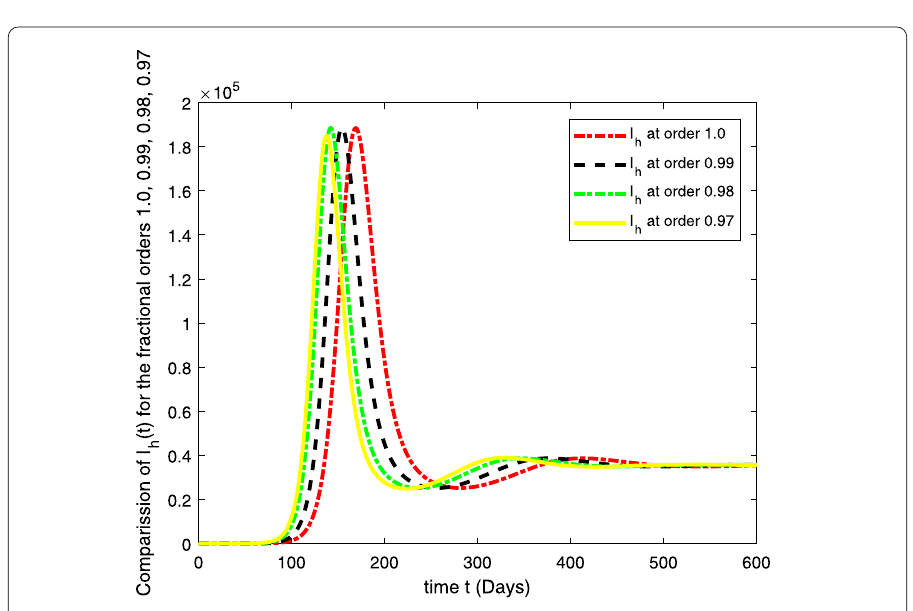
Figure 8 A comparative analysis of I h ( t ) for the fractional orders 1.0, 0.99, 0.98, 0.97